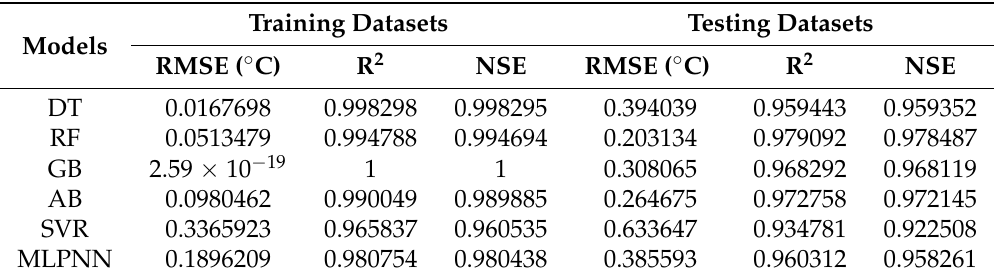
Table 1. Performances of six models (DT: decision trees, RF: random forests, GB: gradient boosting regression, AB: adaptive boosting regression, SVR: support vector regression, MLPNN: multilayer perceptron neural networks) in predicting water